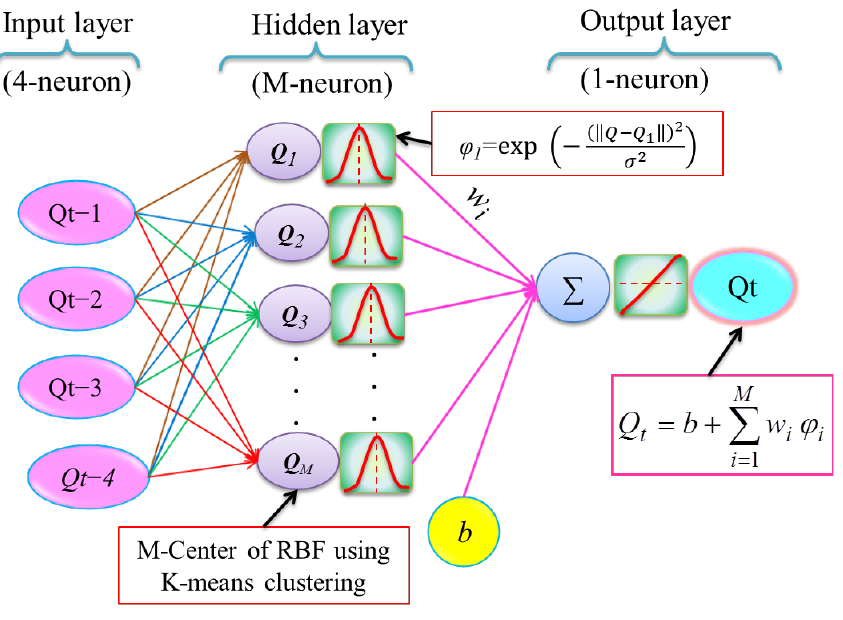
Figure 3. Structure of RBFNN model.